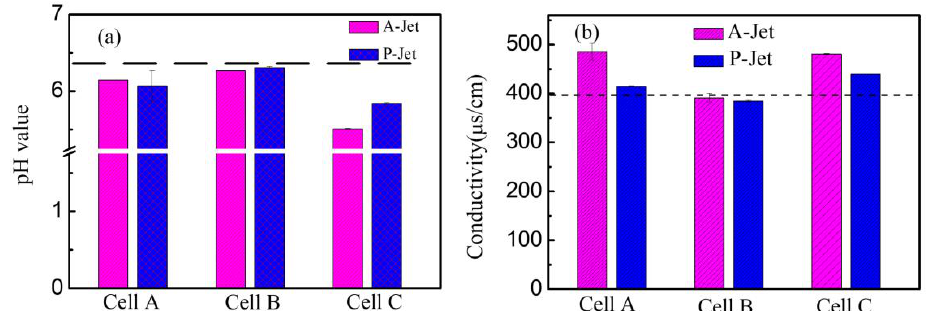
Figure 15. The conductivity and pH value of the different cells at: ( a ) A-Jet for 90 s (voltage: 6.4 kV, frequency: 90 kHz) and ( b ) P-Jet for 7 min (voltage: 8 kV, frequency: 8 kHz). The dashed line represents the initial pH value or conductivity of the mixture without plasma treatment.